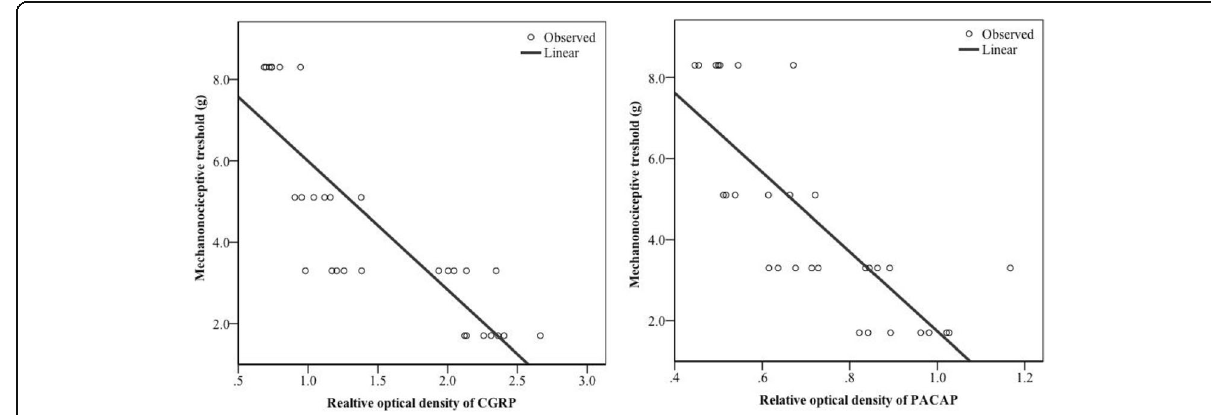
Fig. 6 Negative, linear correlation between expression levels of neuropeptides and mechanonociceptive